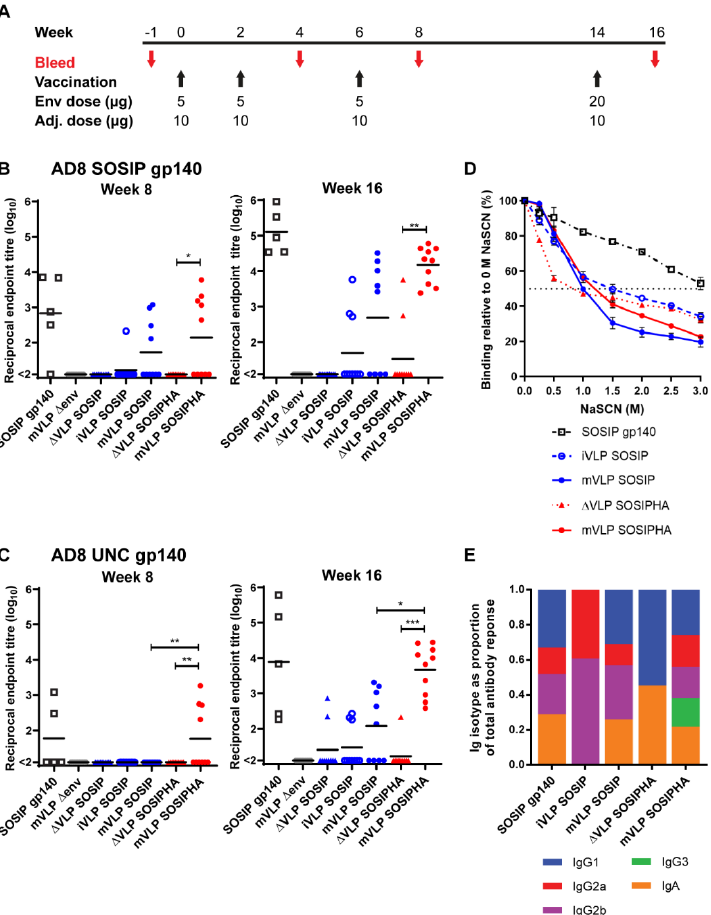
Figure 6. Mouse vaccination schedule and serum Env-specific antibody responses. ( A ) Mice were vaccinated 4 times and blood was collected at the indicated time points. The dose of Env and CpG 1826 ODN adjuvant are indicated below each vaccination (n = 10 per group; except adjuvant-only and SOSIP gp140, n = 5). Reciprocal endpoint serum antibody titers (log 10 -transformed) at week 8 and week 16 against ( B ) D7324-tagged AD8 SOSIP gp140 or ( C ) AD8 UNC gp140 as determined by D7324-capture ELISA. Each point represents an individual animal. The black bar represents the mean titer. The endpoint dilution titer cut-off was defined as 2.5 times the average OD measured for the same serum dilution of the adjuvant-only-vaccination group mice sera sampled at the same time point. The lowest reciprocal dilution assayed was 100 and titers less than 100 were recorded as “<2”. Significance was determined by a Kruskal–Wallis test followed by Dunn’s multiple comparison test. p- values are indicated as p < 0.05 (*), < 0.01 (**), < 0.001 (***). Multiple comparisons were performed as follows: ΔVLP SOSIP vs. iVLP SOSIP, ΔVLP SOSIP vs. mVLP SOSIP, iVLP SOSIP vs. mVLP SOSIP, ΔVLP SOSIPHA vs. mVLP SOSIPHA, and mVLP SOSIP vs. mVLP SOSIPHA. ( D , E ) Week 16 sera from animals with AD8 SOSIP gp140 antibody titers ≥2 were pooled within vaccination groups. ( D ) Sera were analysed in an Env-specific NaSCN-displacement ELISA. D7324-tagged AD8 SOSIP gp140 was captured on the plates. Each sample was diluted to give a similar OD in the absence of NaSCN. Values represent the mean, and error bars show the SEM from 2 independent experiments. ( E ) Isotype-specific reciprocal endpoint serum antibody titers at week 16 were determined using D7324-tagged AD8 SOSIP gp140 in a D7324-capture ELISA. The endpoint dilution titer cut-off was defined as 2.5 times the average OD measured for the same serum dilution of the adjuvant-only-vaccination group mice sera sampled at the same time point. The lowest reciprocal dilution assayed was 100. Titers less than 100 were recorded as “0”. The isotype as a proportion of the total antibody response was calculated by dividing each individual antibody isotype titer by the sum of all antibody isotypes for a given vaccination group. For ( B , C , E ), data are representative of 2 independent experiments.